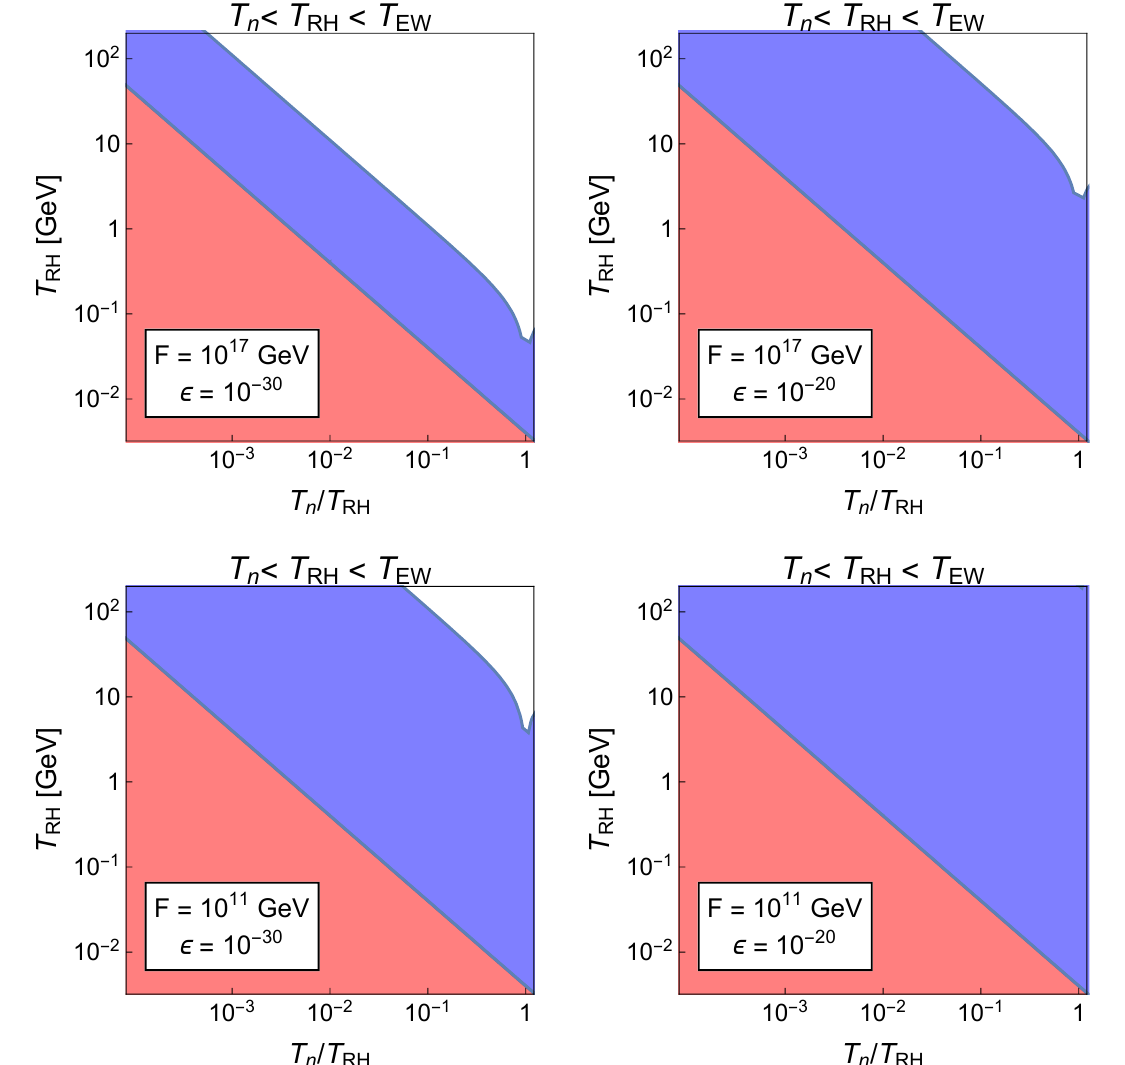
Figure 2. Regions in which the relative variation of the Higgs VEV of eq. (3.10) is larger than unity (blue) and therefore the solution of the hierarchy problem is spoiled and in which the nucleation or the reheating temperatures are smaller than 4 MeV (red). We suppose the initial VEV to be v All the plots show the T case. See the text for more details. n < T RH < T EW